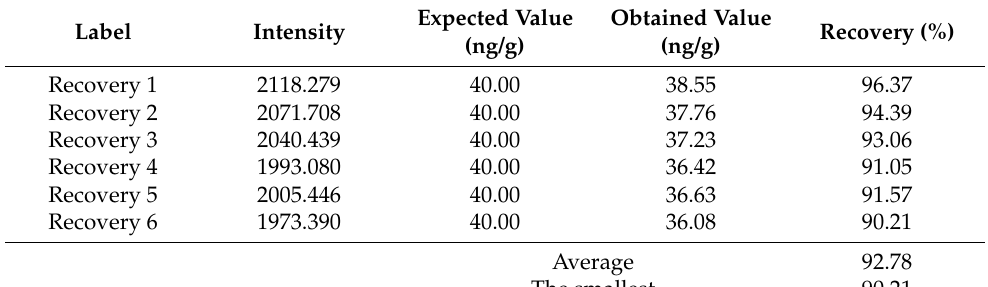
Table 2. Accuration test of the method.